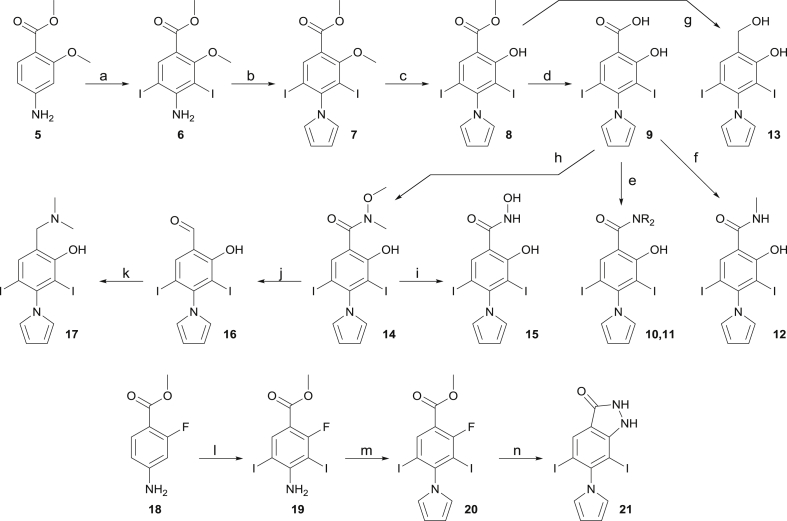
Synthesis of target analogues through functionalization at C1 and C4 for exploration of subsite 1 and subsite 3.aaConditions: (a) NIS, AcOH, rt, quant.; (b) 2,5-dimethoxytetrahydrofuran, AcOH, 80 °C, quant.; (c) BBr3, CH2Cl2, 0 °C, 89%; (d) NaOH, THF/H2O, rt, quant.; (e) EDCI, NHS, CHCl3, amine, rt, 14–26%; (f) methylamine, H2O/MeOH, 84%; (g) NaBH4, CH2Cl2/MeOH, rt, 53%; (h) EDCI, HOBt, N,O-dimethylhydroxylamine hydrochloride, DIPEA, CH2Cl2, rt, 54%; (i) hydroxylamine, THF/H2O, rt, 85%; (j) DIBAL-H, THF, −78 °C to rt, 54%; (k) dimethylamine, AcOH, NaB(OAc)3H, CH2Cl2, rt, 67%; (l) NIS, AcOH, rt, quant.; (m) 2,5-dimethoxytetrahydrofuran, AcOH, 80 °C, quant.; (n) hydrazine monohydrate, Et3N, CH2Cl2/EtOH, 75 °C, 51%. Refer to Table 1 for R groups.